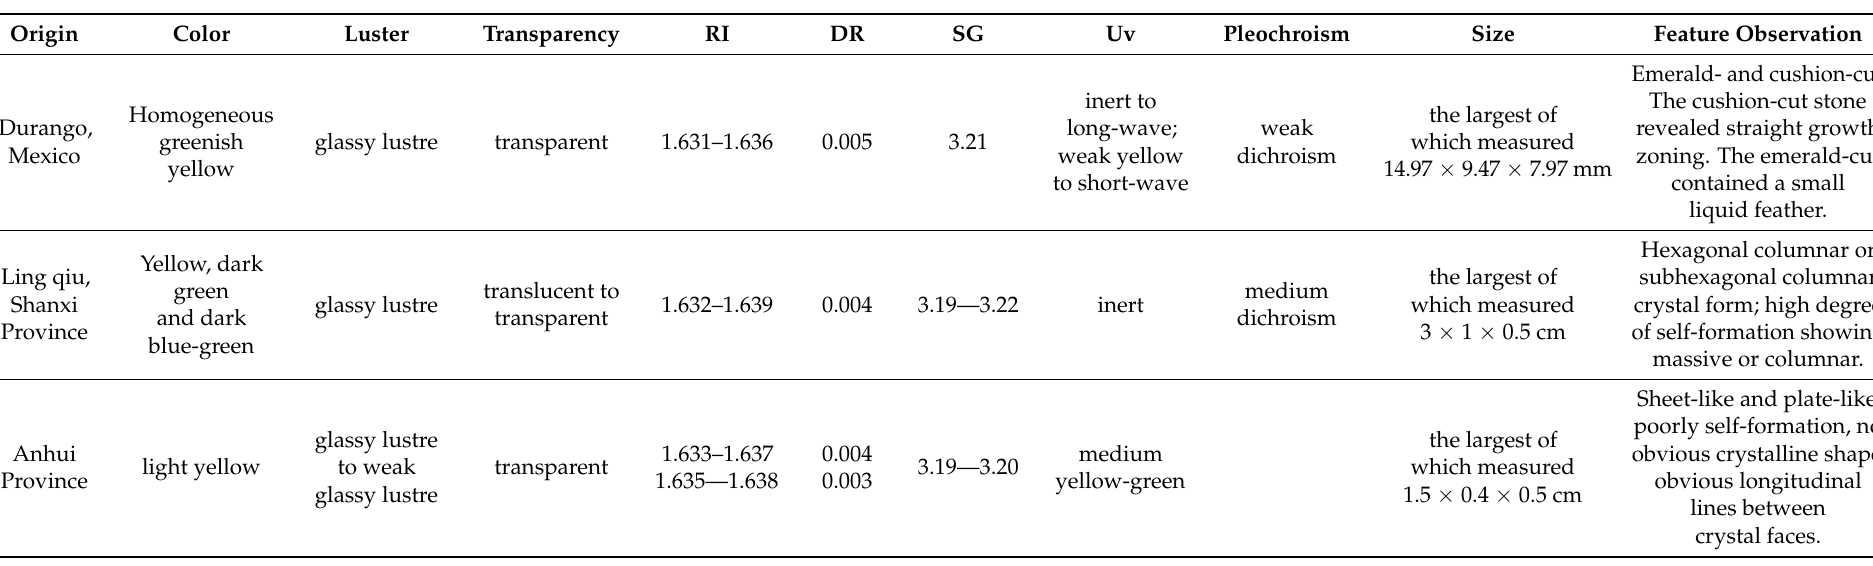
Table 4. Characteristics of apatite from different production